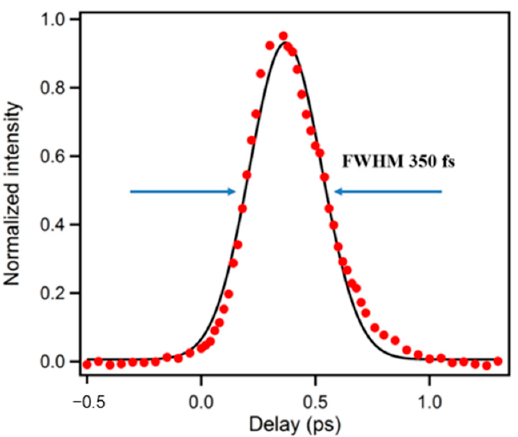
Figure 2. A typical pulse response function of upconversion